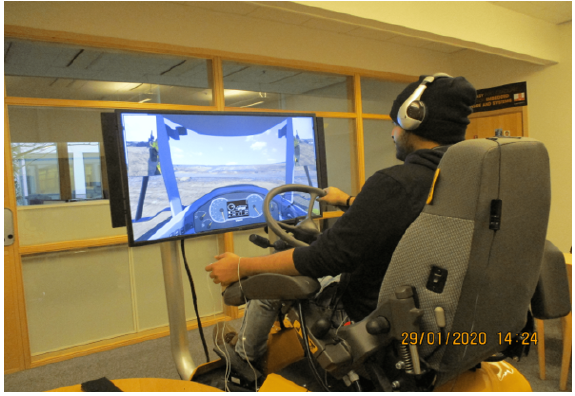
Figure 4. Articulated dump truck simulator.